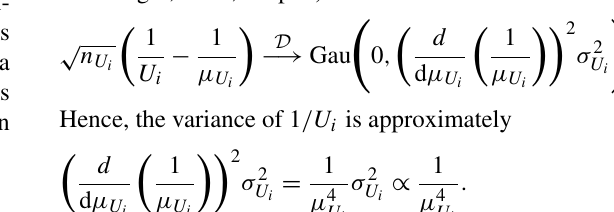
Table 1. Stability classes to which observations within the Ginninderra experiment are allocated, and the corresponding values of a k and d k used to construct the horizontal (σ y i